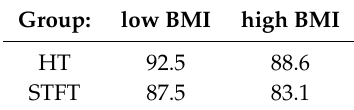
Table 7. Comparison of the average F 1 -score (in %) of the two groups with low and high BMI.